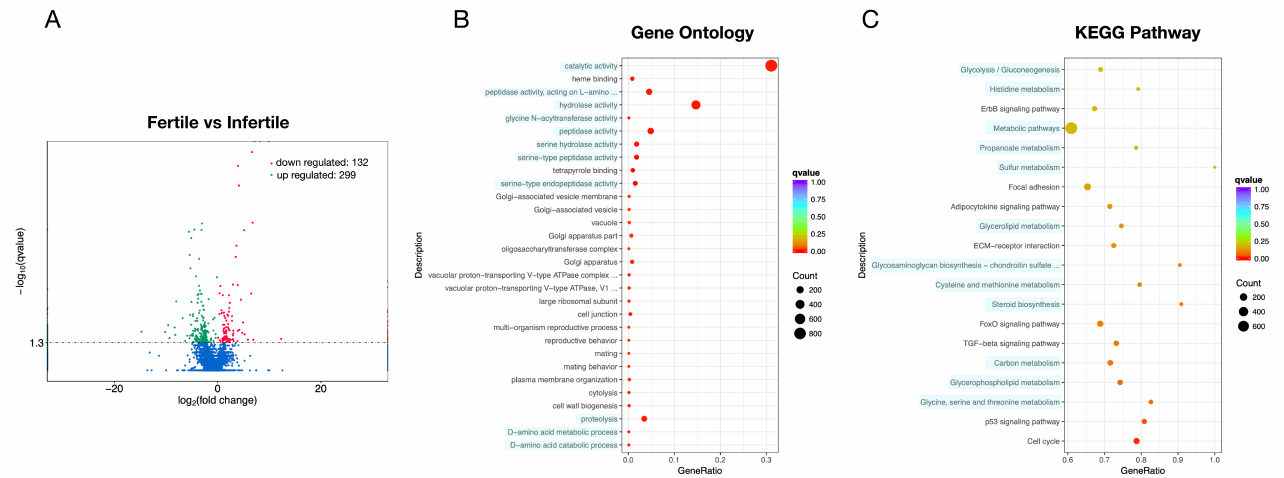
Figure 3. Volcano plot and GO/pathway analysis for target genes of DE long non-coding RNAs (lncRNAs) between infertile and fertile group in Paralichthys olivaceus . ( A ) Volcano plot for target genes of DE lncRNAs. The red spots, green spots, and blue spots separately represent down-regulated, up-regulated and undifferentiated target genes of DE lncRNAs. ( B ) Top 30 changed GOs for target genes of DE lncRNAs. ( C ) Top 20 changed pathways for target genes of DE lncRNAs.